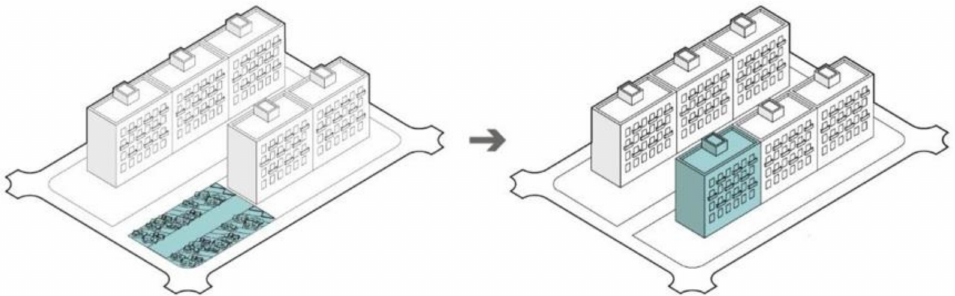
Figure 8. Supposed CAVs’ effect on high-density residential areas